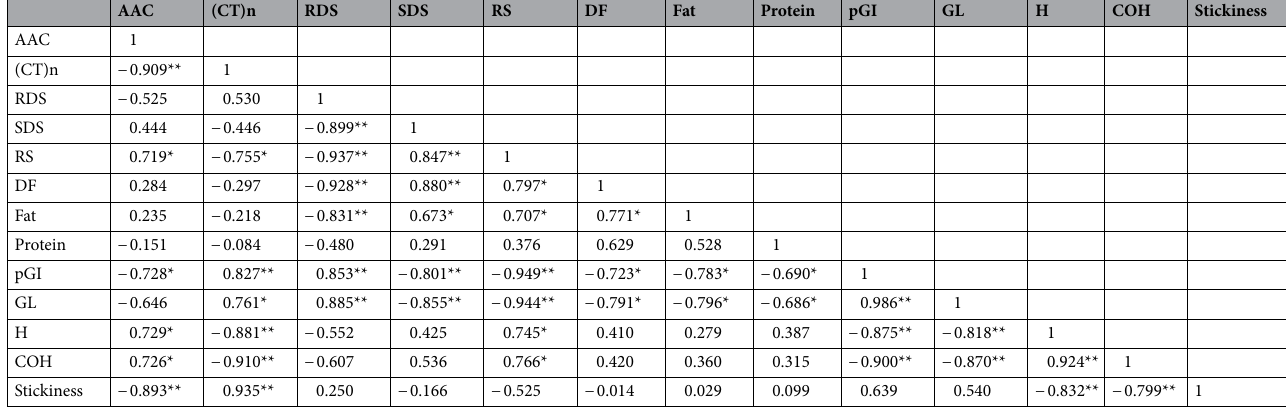
Table 4. Variation in rapidly digestible starch (RDS), slowly digestible starch (SDS), resistant starch (RS) and total starch (TS) of different rice varieties. Mean values within the columns with different superscripts differ significantly at p <